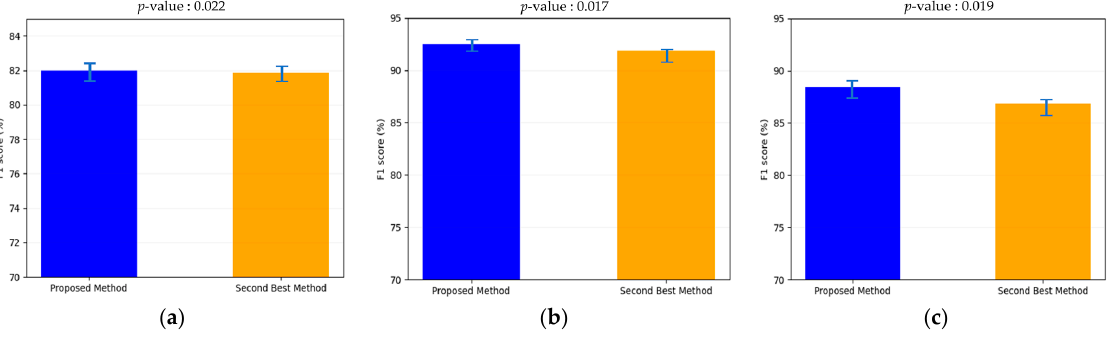
Figure 14. The t -test results between F1 scores of the proposed method and the second-best method in case of ( a ) coin database, ( b ) bill database, and ( c ) coin and bill database.